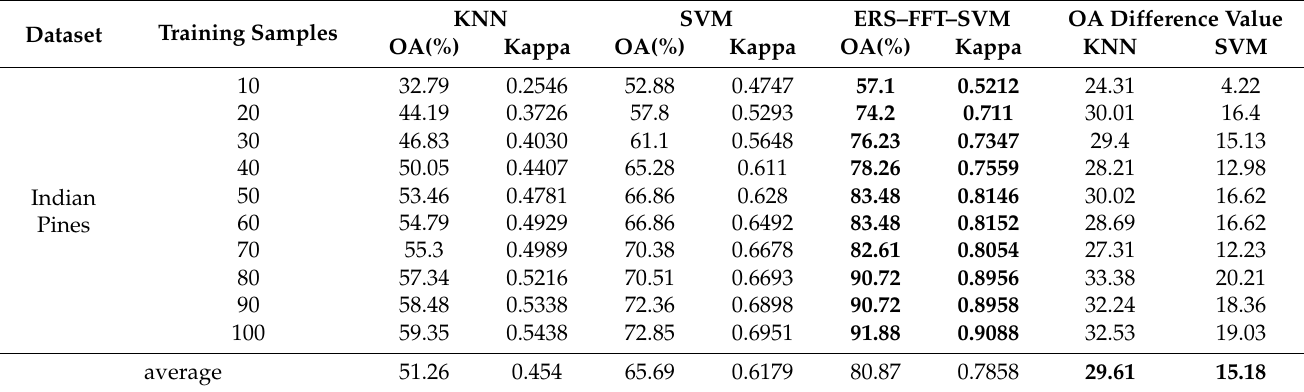
Table 3. Overall classification accuracy and Kappa coefficient of classification algorithms under different sample numbers with the Indian Pines dataset ( K =